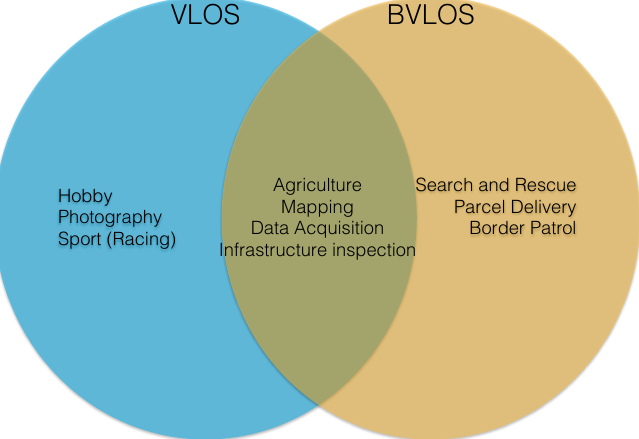
Figure 2. Visual line-of-sight (VLOS) and beyond VLOS (BLOS) categorisation for several common Unmanned Aircraft System (UAS) applications. Some of these application can be considered in the intersection of the two categories, i.e., can be performed by either VLOS or BVLOS.